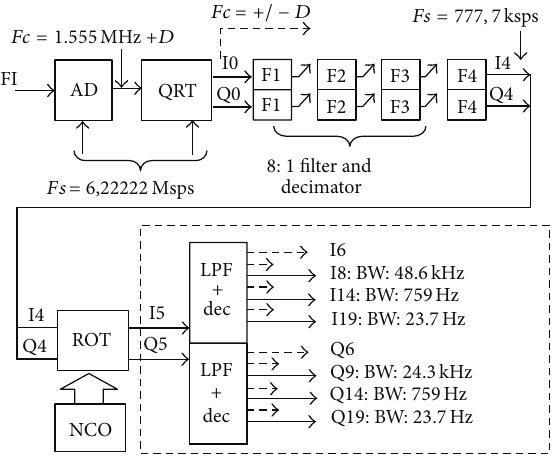
Figure 1: The complete processing